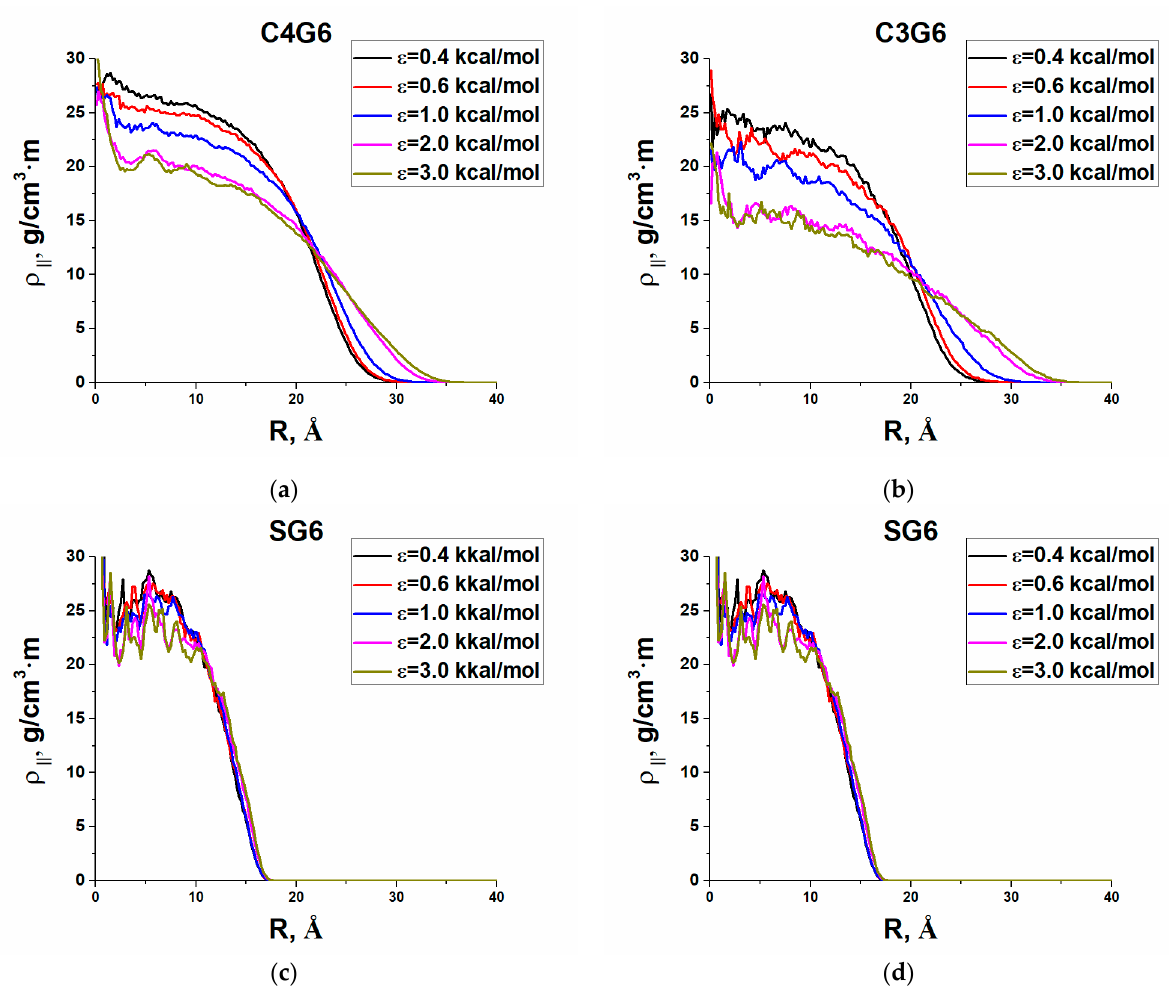
Figure 7. Density profiles ρ ∥ ( R ) parallel to the surface for the sixth generation of ( a ) the C4 dendrimer, ( b ) the C3 dendrimer, ( c ) the S-dendrimer, and ( d ) the L -dendrimer.